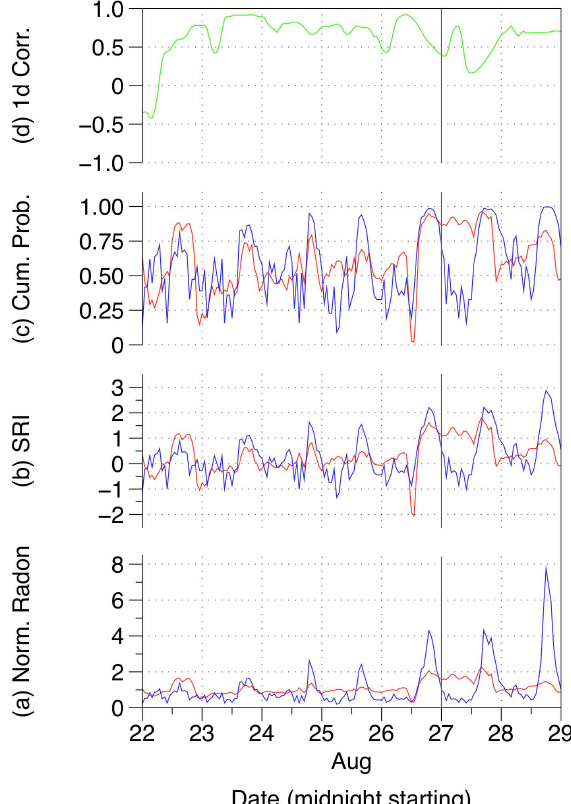
Fig. 4. Late September Radon Anomalies: (a) Normalised Radon, (b) SRI, (c) Cumulative Probability, (d) windowed 1-day correla- tion. TS1a and TS1b are shown in red and blue respectively in graphs (a–c) . The vertical grey lines show the timing of the Dudley Earthquake of 22 September 2002 and its two